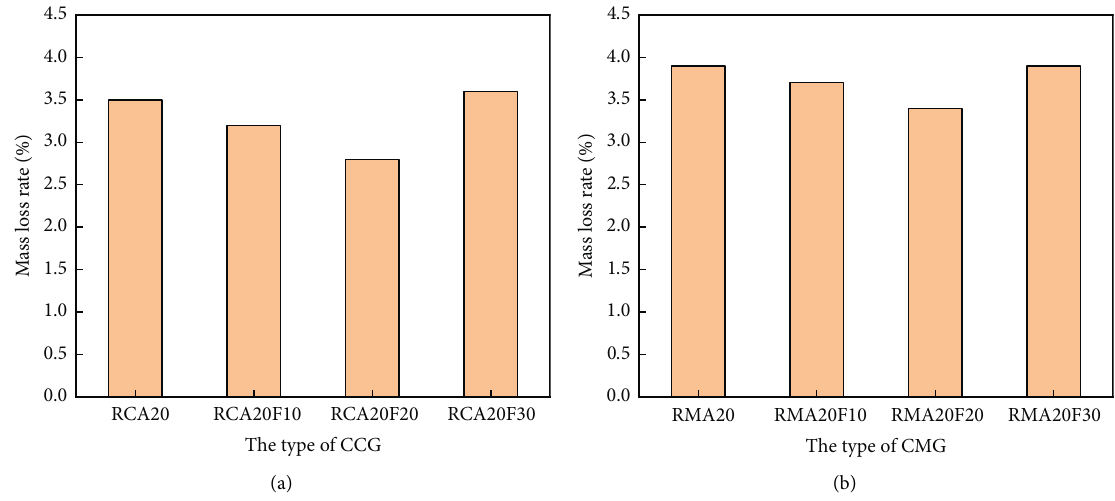
Figure 8: The mass loss rate of CCG and CMG with different content of fly ash. (a) CCG, (b)